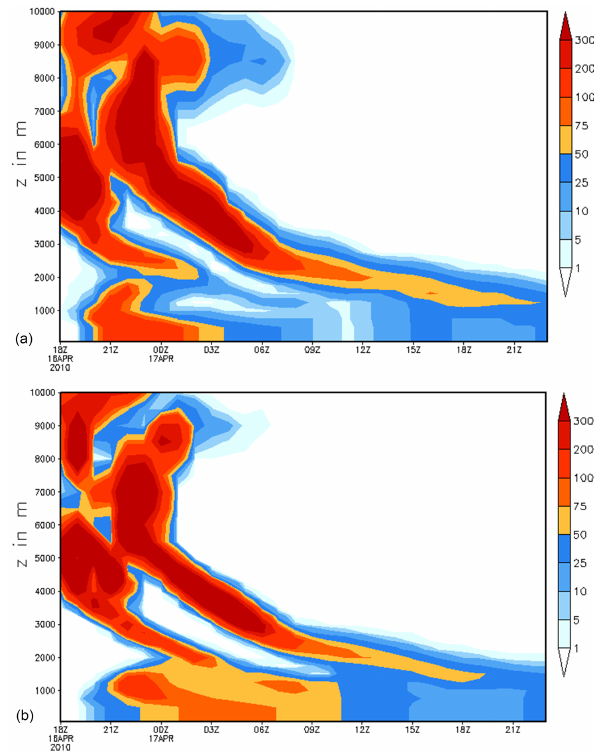
Figure 3. Vertical cross-section of the non-calibrated ash concentra- tion (arbitrary units) at Munich for different model configurations. (a) reference run with 40 vertical layers, (b) model run with 80 ver- tical